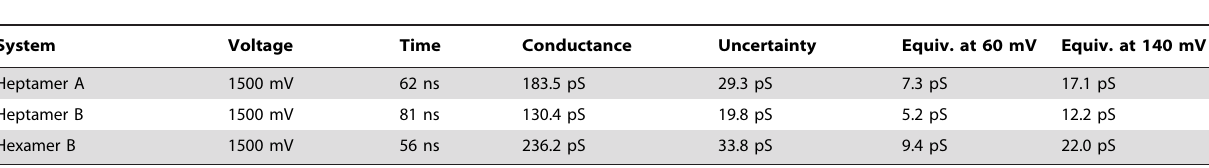
the simulated conductance values to match the specific values obtained experimentally. In experimental conductance measure- ments, it is impossible to know the proportion of heptamers to hexamers in the sample, and the resulting measurement represents an ensemble average of the action of all the oligomers in the sample. By contrast, MD simulations can only report the behavior of one specific structure. Additionally, the treatment of ions in MD with the standard, non-polarizable CHARMM force field is Table 3. Conductance simulations performed.